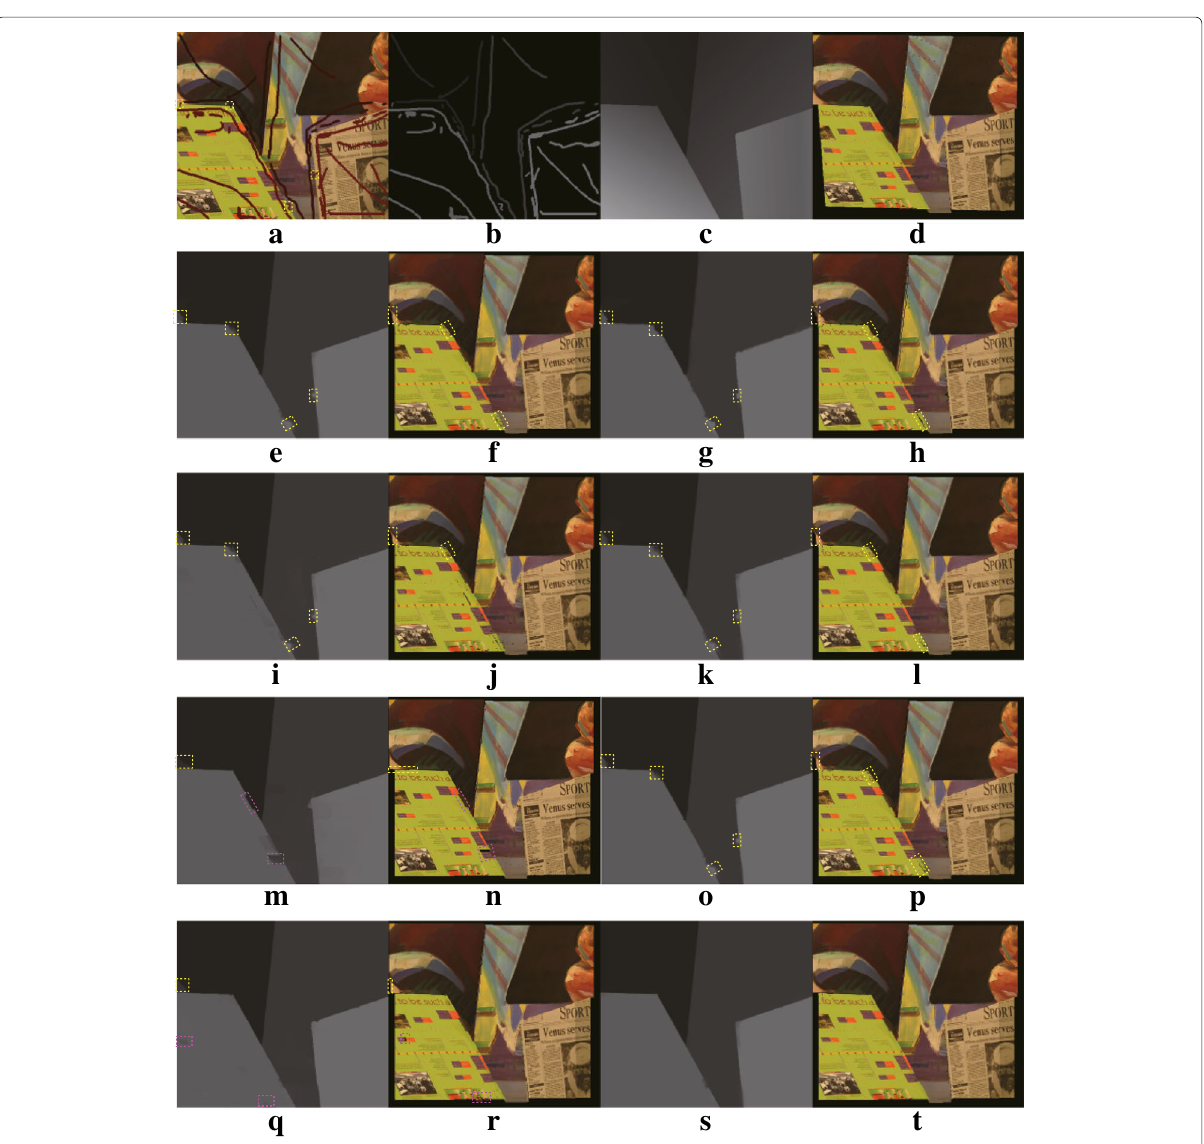
Fig. 14 Results of Venus with cross-boundary input. a User-labeled image. b Sparse depth. c Groundtruth depth. d Synthesized view using c . e Depth of RW. f Synthesized view using e . g Depth of HGR. h Synthesized view using g . i Depth of NRW. j Synthesized view using i . k Depth of OPT. l Synthesized view using k. m Depth of OCP. n Synthesized view using m. o Depth of SDF. p Synthesized view using o. q Depth of (cid:2) 1 . r Synthesized view using q. s Depth of the proposed method. t Synthesized view using s. Please zoom in to see